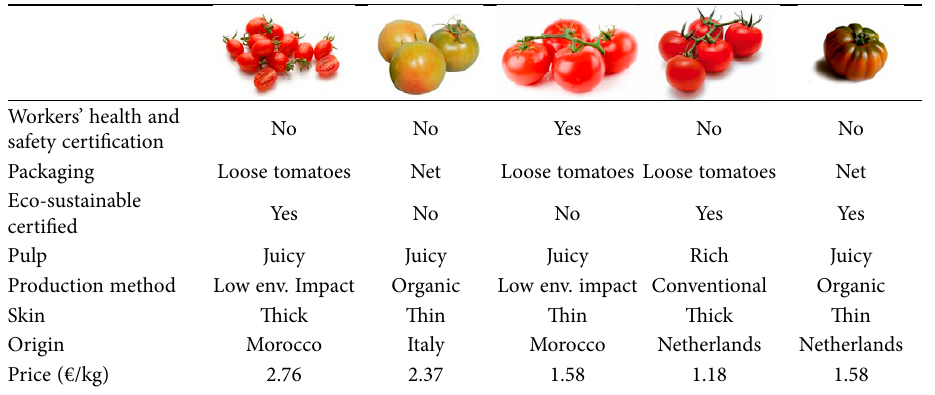
Figure 1. Example of a choice card.